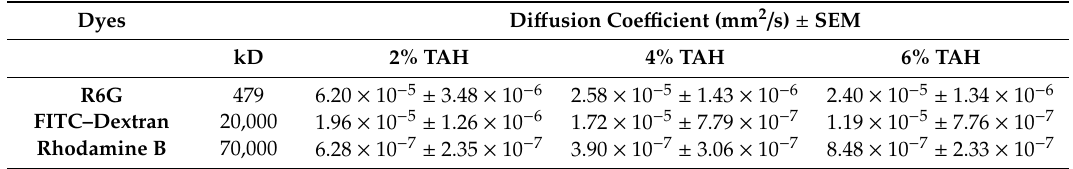
Table 1. Di ff usion Coe ffi cients of Fluorescent Compounds with Di ff erent Molecular Weights in